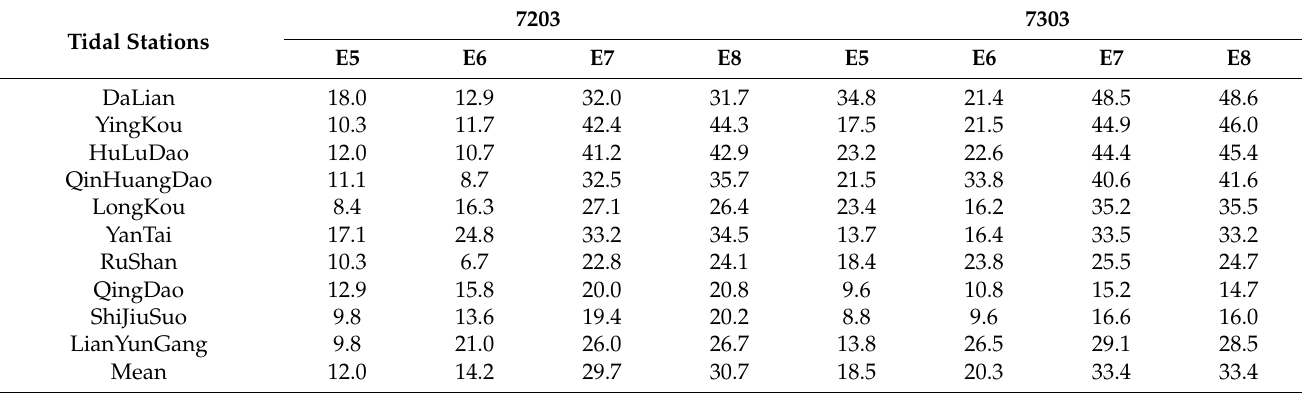
Table 8. Root–mean–square errors between simulated and observed storm surge levels at 10 tidal stations during Typhoons 7203 and 7303 (unit: